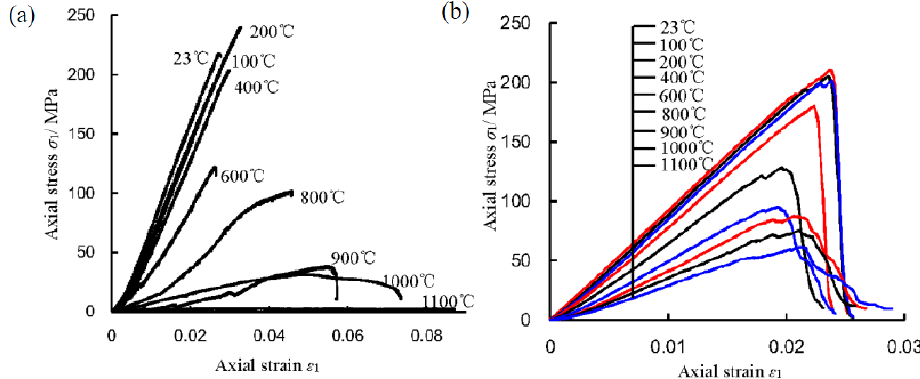
Figure 11. Comparison of the experimental and numerical stress-strain curves of Strathbogie granite at different temperatures under uniaxial compression: ( a ) experimental results [25]; and ( b ) numerical results.